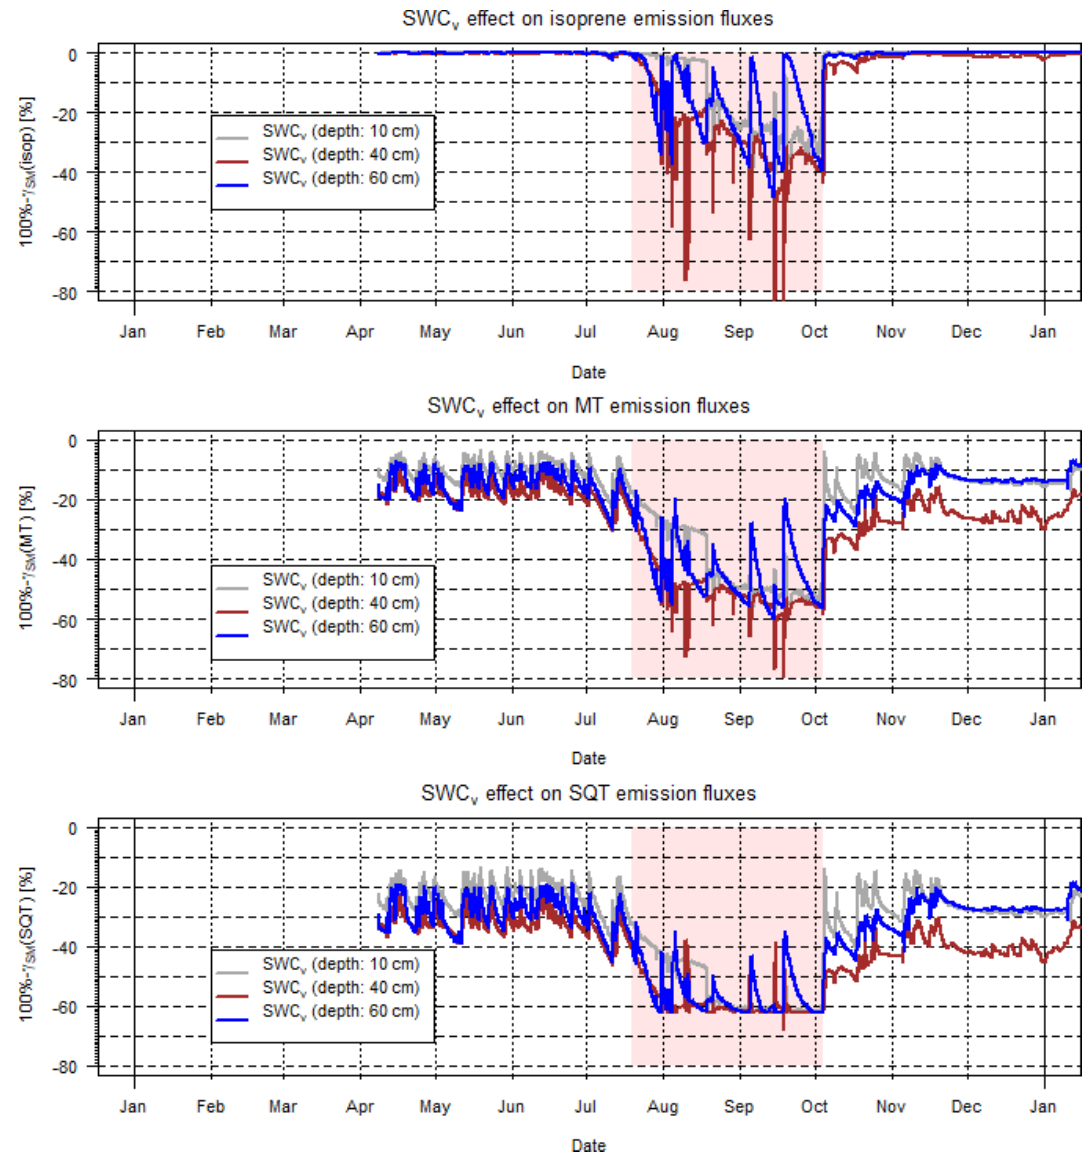
Figure 7. Calculated γ SM effects during 2016 at Freiamt on isoprene, total MT and SQT emission rates. Note that there were two induced drought periods during the summer and quite saturated conditions otherwise. The applied drought period is indicated by a reddish